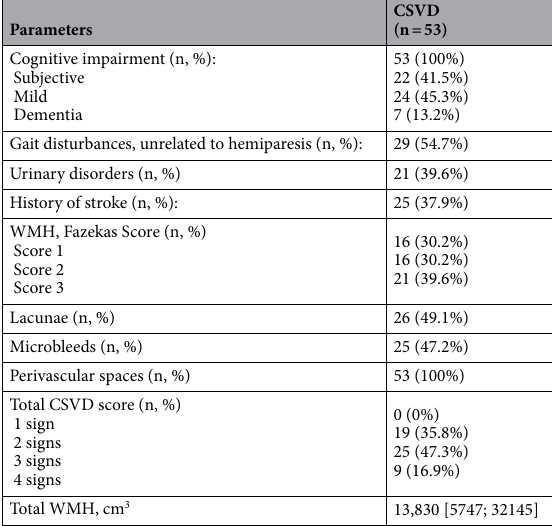
Table 2. Clinical symptoms and MRI signs in patients with CSVD.